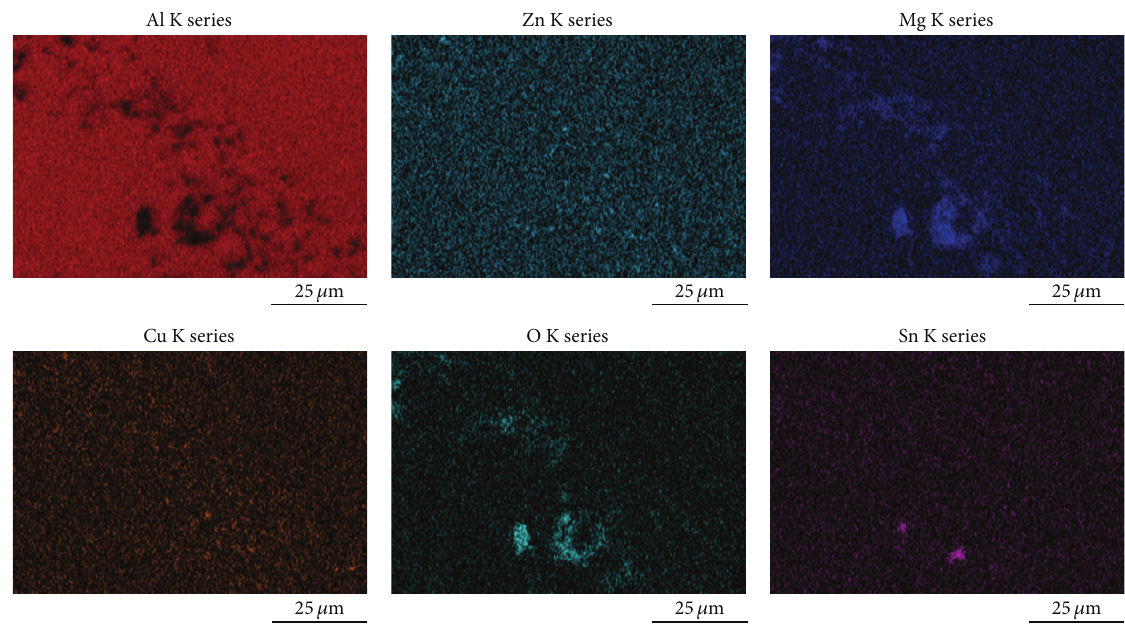
Figure 5: Elemental distribution analysis by EDS of sintered Alumix 431D starting with Al, Zn, and Cu which homogenously dispersed throughout the surface and Mg, O, and Sn seem to be concentrated at certain places on the surface.